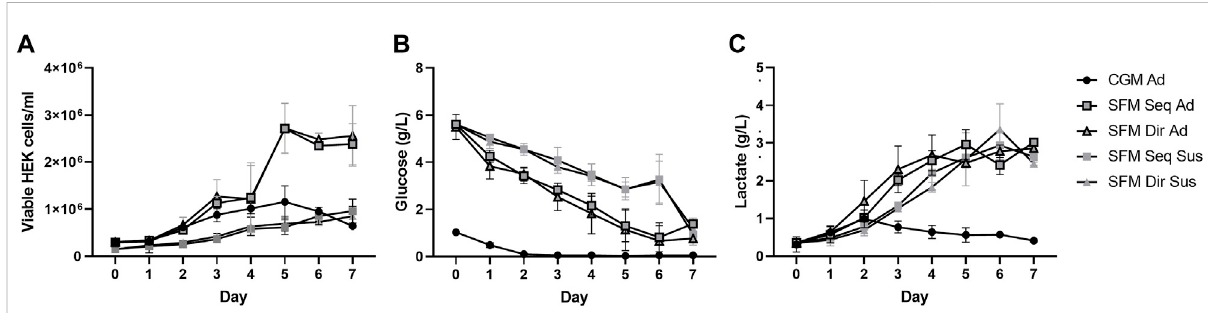
FIGURE 4 Cell growth was pro fi led for 7 days of batch cultivation in 5 different culture systems. (A) Cell growth kinetics, (B) Extracellular glucose, and (C) Lactate levels were measured every day of cultivation. All data represent average ±standard deviation. ( n = 3).